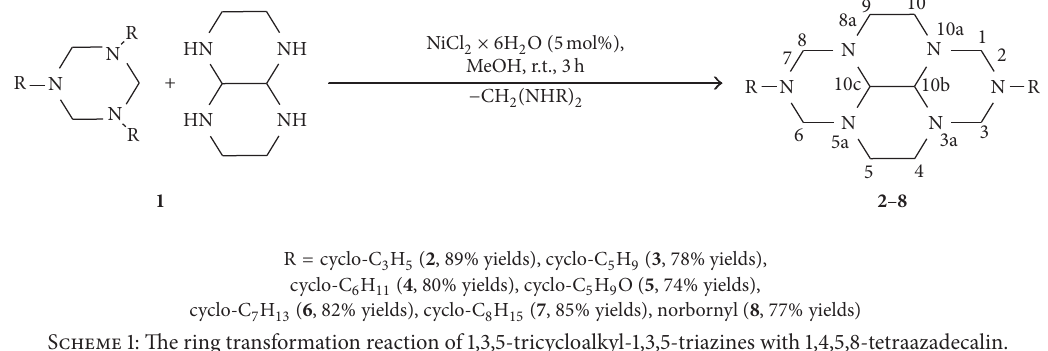
Scheme 1: The ring transformation reaction of 1,3,5-tricycloalkyl-1,3,5-triazines with 1,4,5,8-tetraazadecalin.